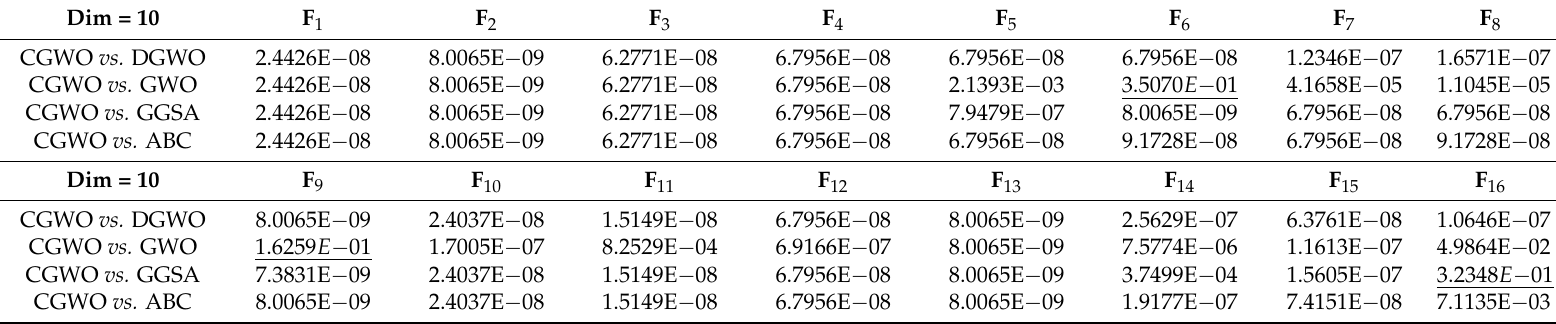
Table 6. p -values produced by Wilcoxon rank-sum test comparing CGWO (complex-valued encoding grey wolf optimization) vs. DGWO (differential evolution GWO), GWO, GGSA(gbest-guided gravitational search algorithm), and ABC (artificial bee colony optimization)minimization results of the multimodal benchmark functions at Dim = 10 ( p ě 0.05).